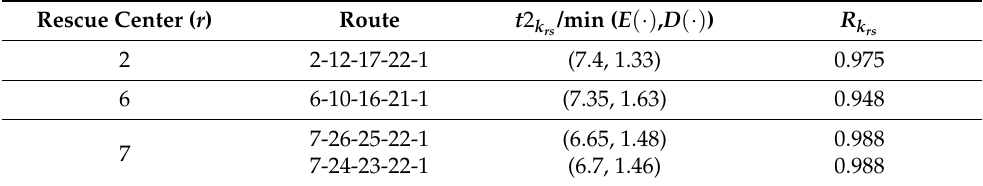
Table 11. Feasible routes and their reliability for rescue resource 4.